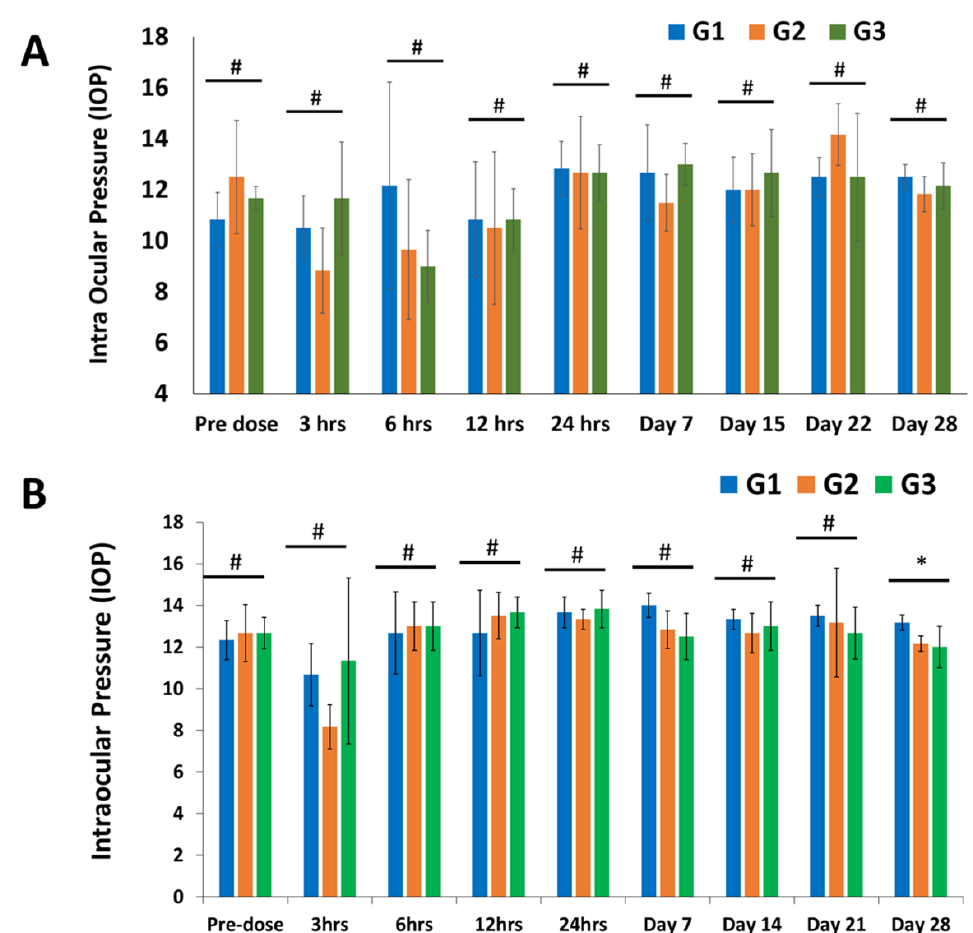
Figure 6. Changes in the intraocular pressure of the rabbits at different study time points. ( A ) Intraocular pressure (IOP) was monitored before and after treatment and is depicted as a bar graph. Comparing the experimental groups (G2 and G3) to the control group, no statistically significant differences were found in IOP levels (G1). n = 6; * p < 0.05, # p > 0.05. ( B ) Intraocular pressure (IOP) variations in healthy eyes, represented as a bar graph. Except for one time point, there were no statistically significant differences between the IOP levels of the experimental groups (G2 and G3) and the control group (G1) (Day 28). n = 6; * p < 0.05, # p > 0.05. G1—Sham treated